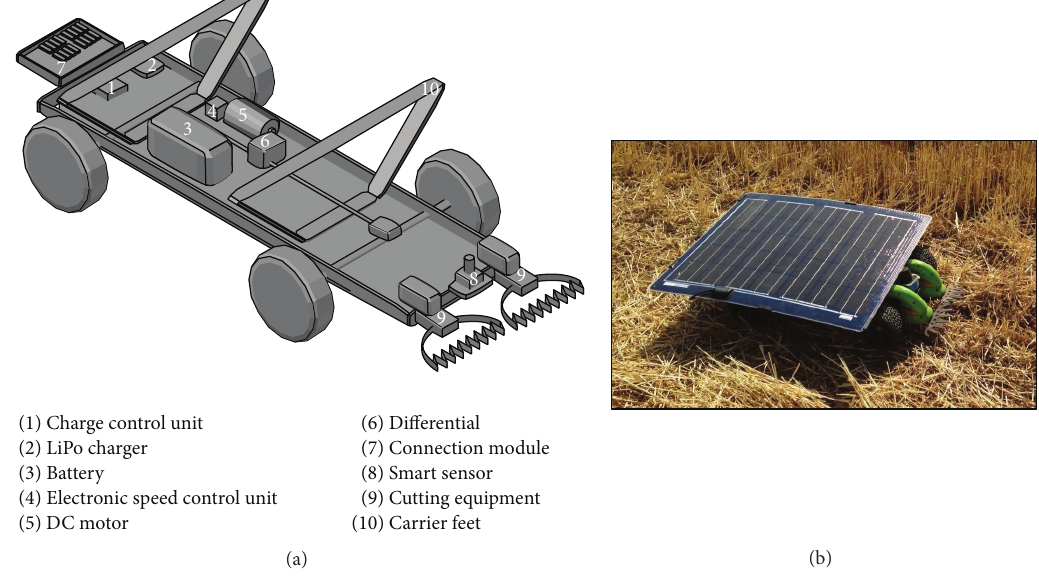
Figure 1: SPWM system, (a) prototype scheme and (b) photograph.